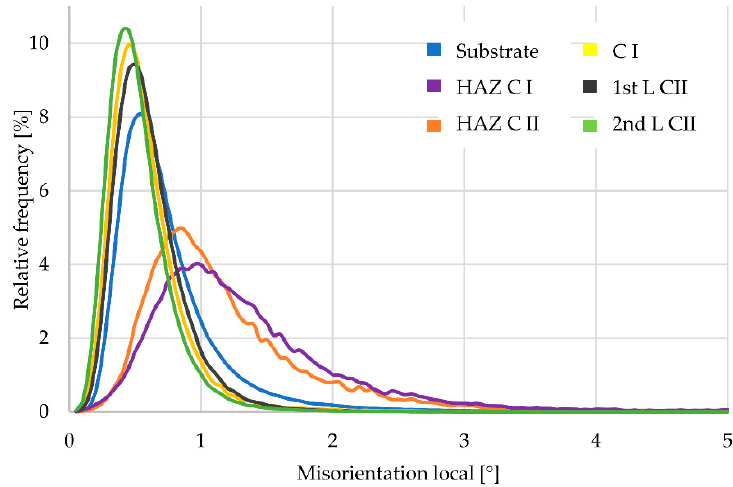
Figure 14. Distributions of kernel average neighbor misorientations of the substrate ( S ) not affected by heat; the heat affected zones (HAZ) of the substrates ( S ) of clad I and II; clad I; and the first and second layers of clad II (1st L C II and 2nd L C II, respectively).